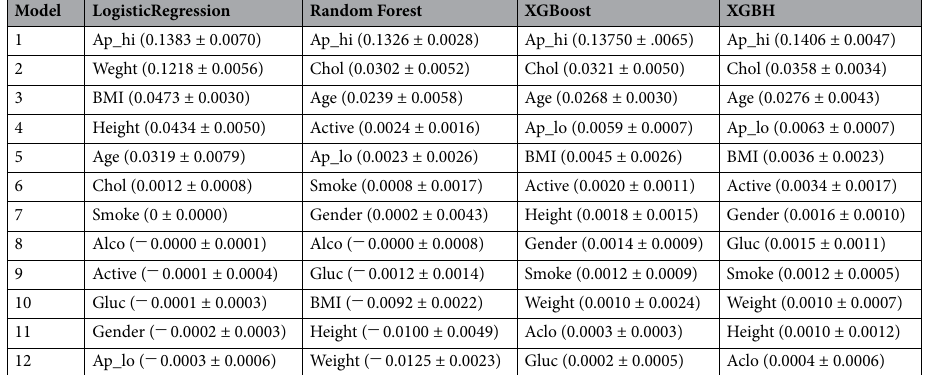
Table 3. Feature importance of each prediction. The value of weight plus or minus represents the half of 95% confidence interval length. The larger the feature weight, the greater the feature predictability, and the negative weight represents an inhibitory effect on